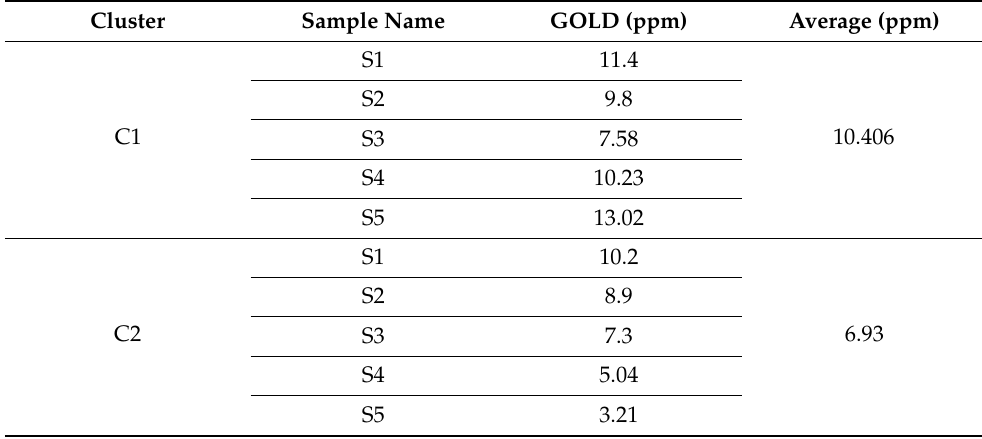
Table 6. Gold concentrations in pan concentrate samples of the study area.